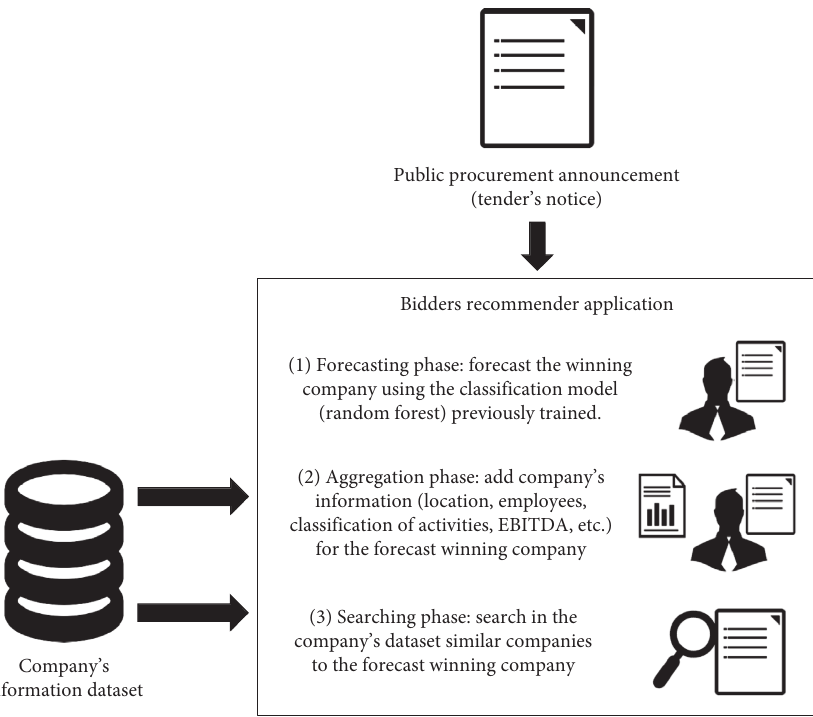
Figure 1: Flowchart of the application of the bidders recommender for a new